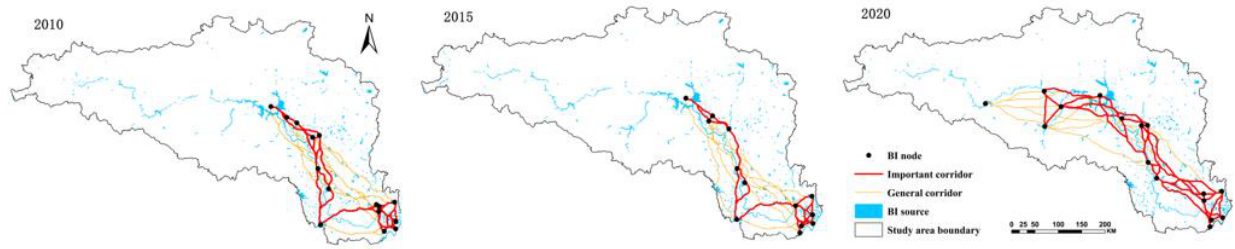
Figure 5. BI network of the study area.